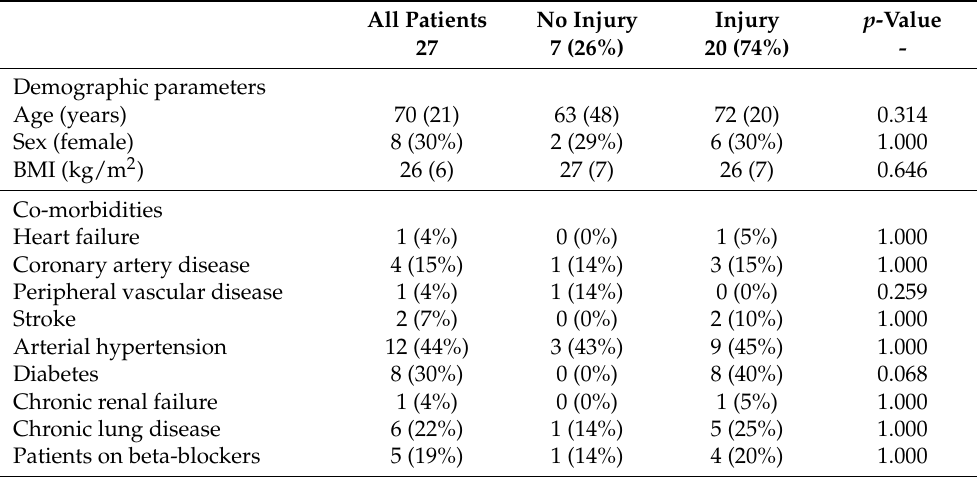
Table 1. Patient characteristics at ICU admission. Part I. Data are presented as median (interquartile range) or number (percentage). BMI—body mass index.